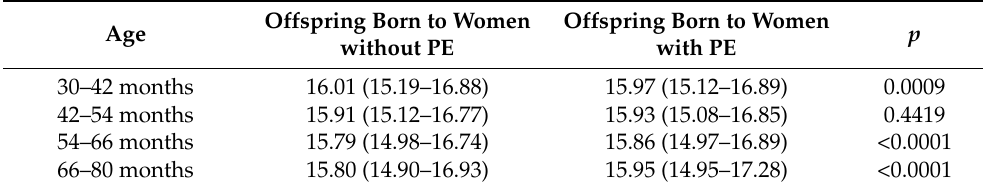
Table 2. Body mass index of offspring up to 80 months of age stratified according to maternal preeclampsia